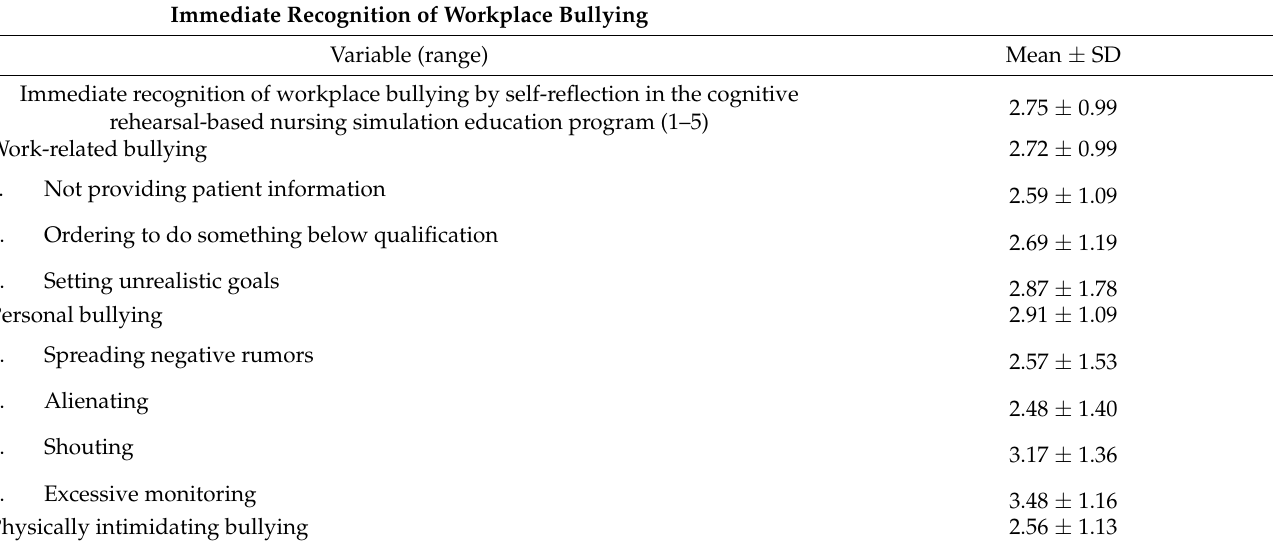
Table 3. Immediate recognition of workplace bullying and self-reflection ( N =